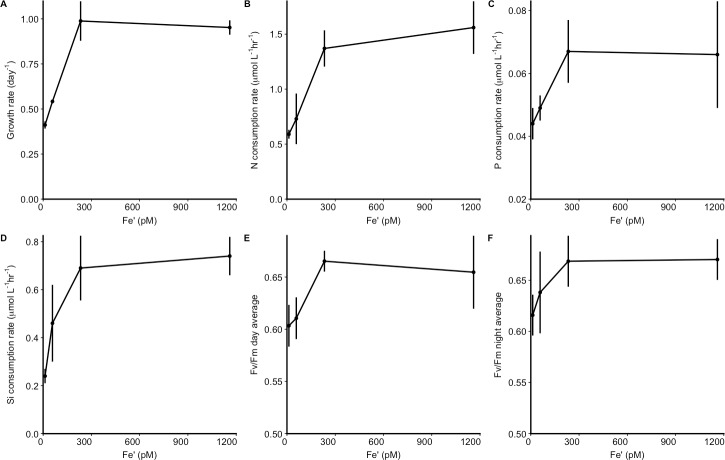
The impact of Fe’ concentrations (in pM) on different physiological parameters.(A). Growth rate (day-1) and (B) nitrate, (C) phosphate and (D) silicate consumption rates (in μmol L-1 hr-1), average of Fv/Fm measured during the (E) day or (F) night during exponential growth. Error bars (A-D) represent standard deviation of the triplicates. Error bars for Fv/Fm (E. F) represent the square root of the variances for each measurement used in the average.